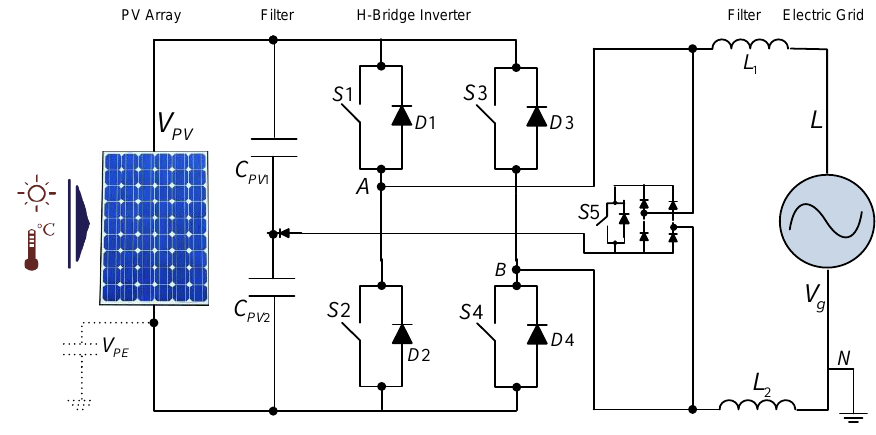
Figure 15. Schematic diagram of the FB-ZVR inverter [43,56].